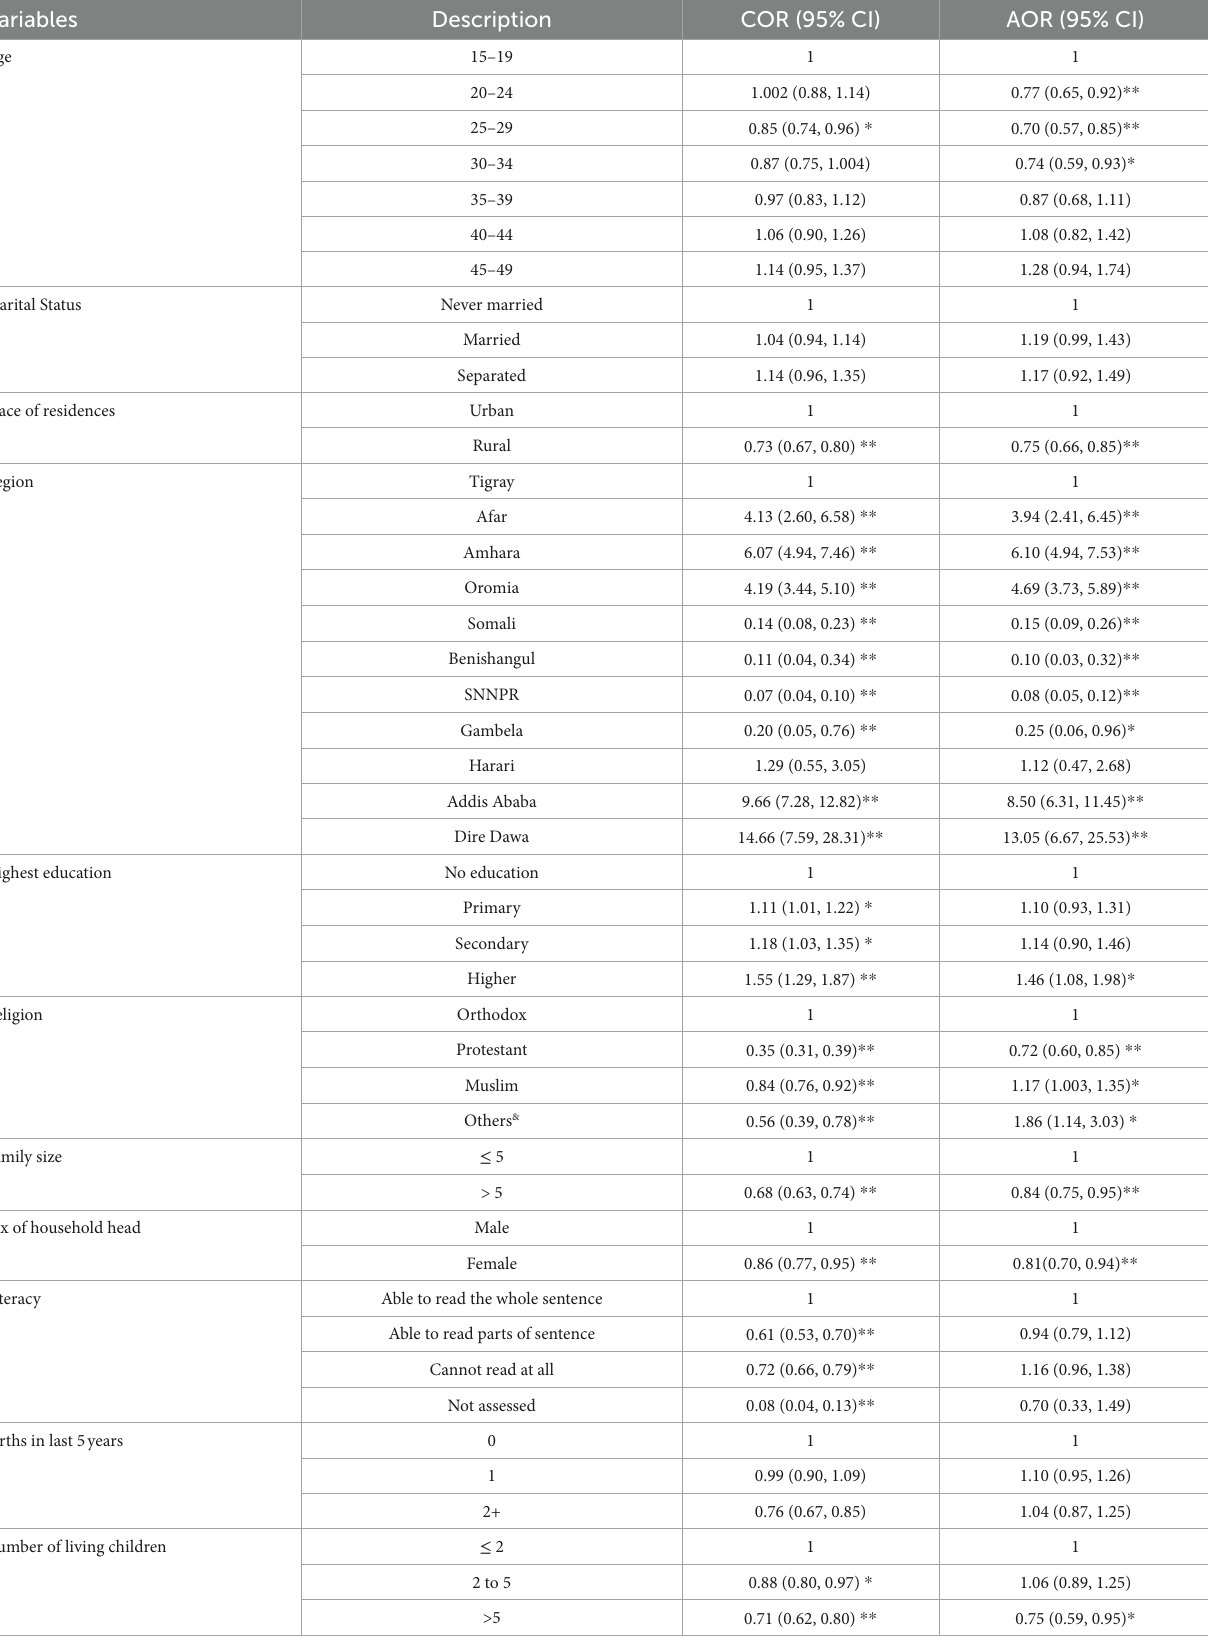
TABLE 2 Multivariable logistic regression of factors associated with CBHI enrolment among reproductive age women in Ethiopia, 2019 ( n = 8885).